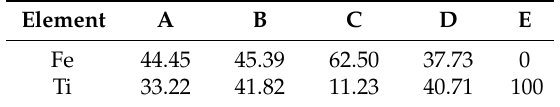
Figure 10. Energy dispersive spectrometer(EDS) spectra of ( a ) region A, ( b )region B, ( c ) region C, and ( d ) region D. Table 5. Experimental atomic fraction of Fe and Ti for various location in Figure 7 (at. %). Element